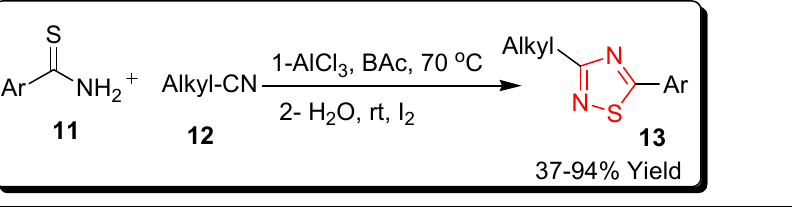
thiophene thiophene Scheme 4. One-pot green synthesis of 3,5-disubstituted 1,2,4-thiadiazoles. Scheme 4. One-pot green synthesis of 3,5-disubstituted 1,2,4-thiadiazoles. Scheme 4. One-pot green synthesis of 3,5-disubstituted 1,2,4-thiadiazoles.